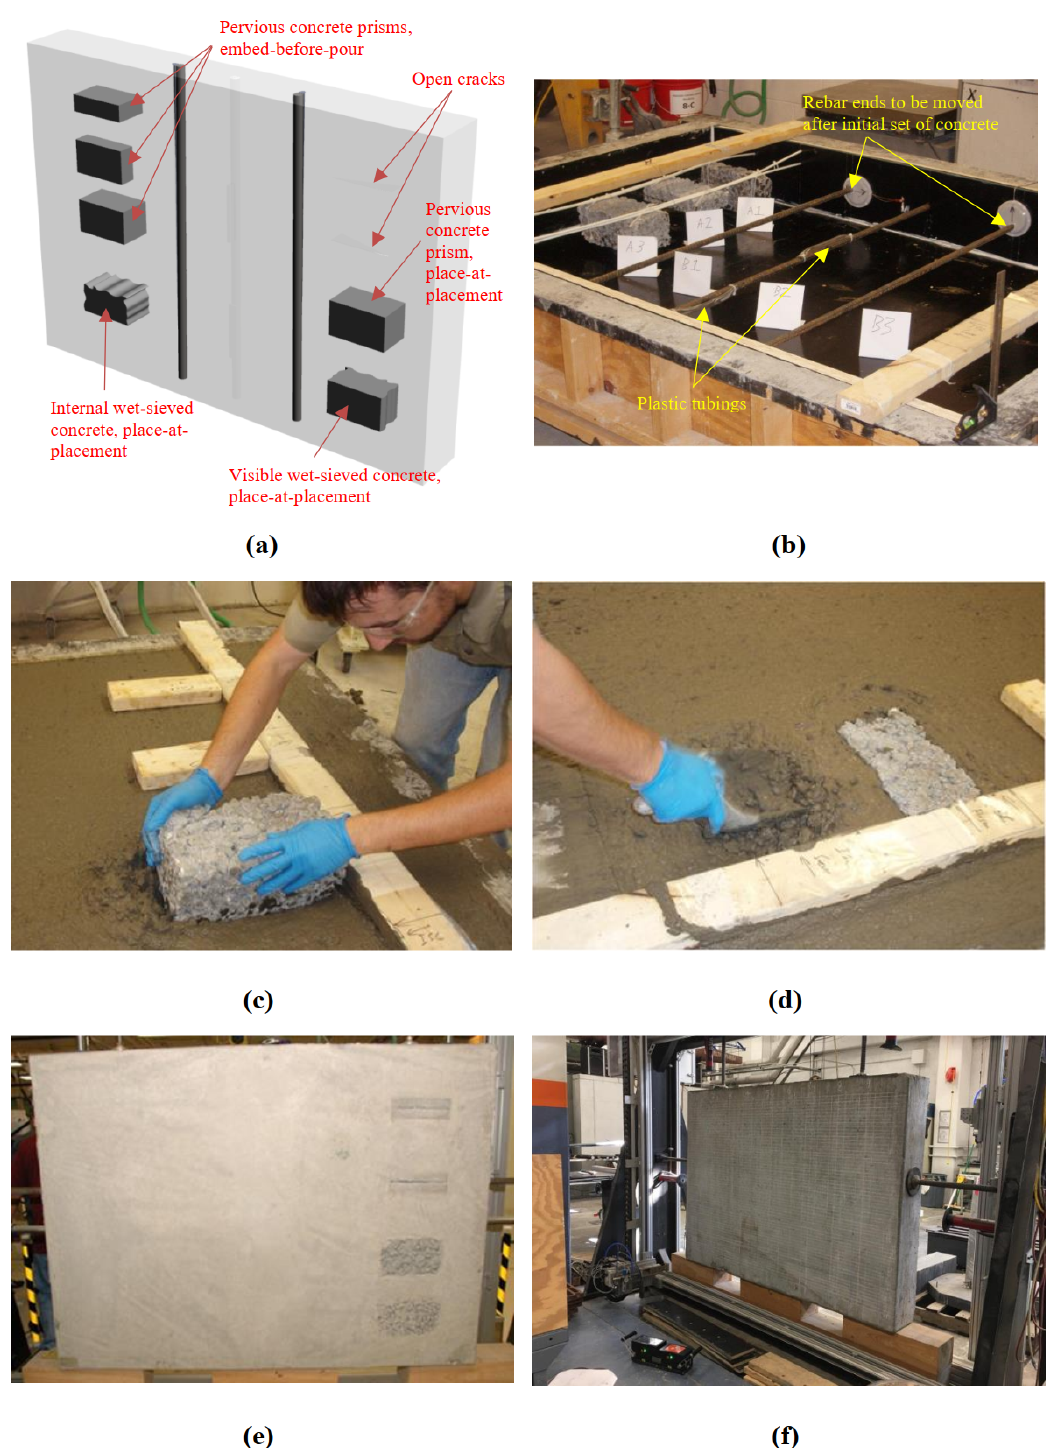
Figure 11. Slab 6: ( a ) 3D rendering, ( b ) before casting, ( c ) installing pervious concrete prism, ( d ) installing wet-sieved concrete into the surface to more realistically simulate poor consolidation, ( e ) view of finished slab bottom [42], ( f ) view of survey grid.